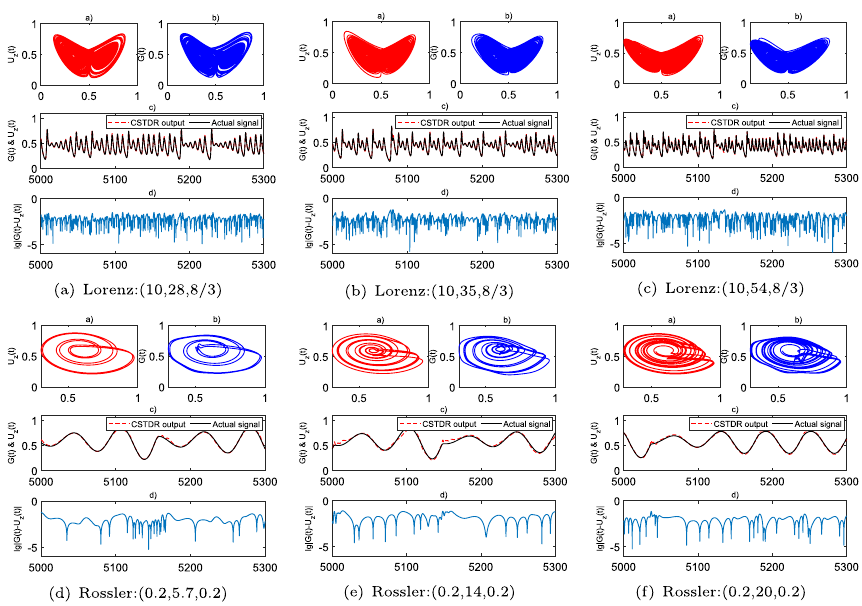
Fig. 4 Synchronization results between actual chaotic signal and output of CSTDR computing with Lorenz and Rossler system using different parameters. a and b in a , b and c : Chaotic attractors of the original Lorenz system and the trained CSTDR computing, respectively; c in a , b and c : Plot of time-varying output signal and actual chaotic signal of Lorenz system; d in a , b and c : Plot of time-varying differences between output signal of CSTDR and actual signal in Lorenz system. Captions of a , b and c with replacing the Lorenz with Rossler apply to d , e and